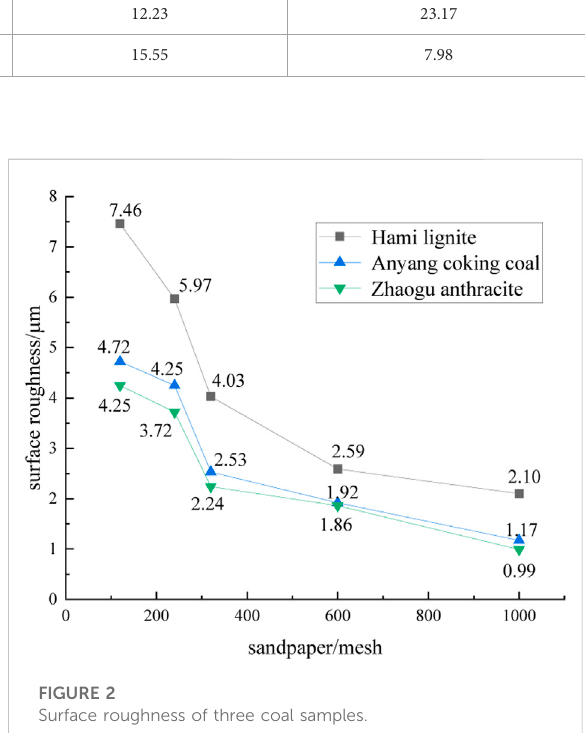
FIGURE 1 Optical contact angle topography instrument.